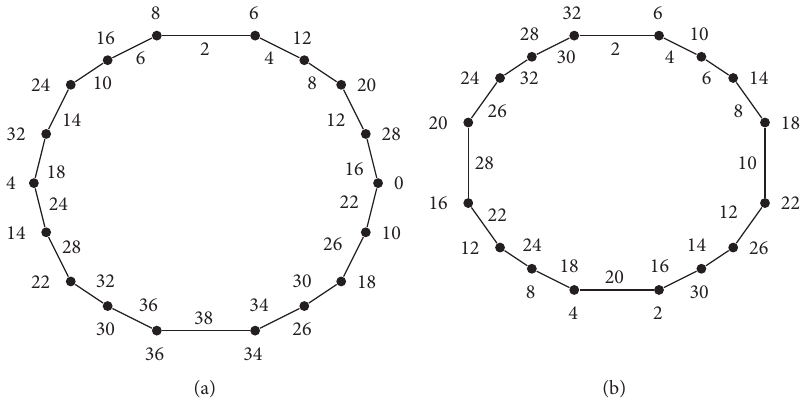
Figure 18: (a) A 2-edge even graceful labeling of C